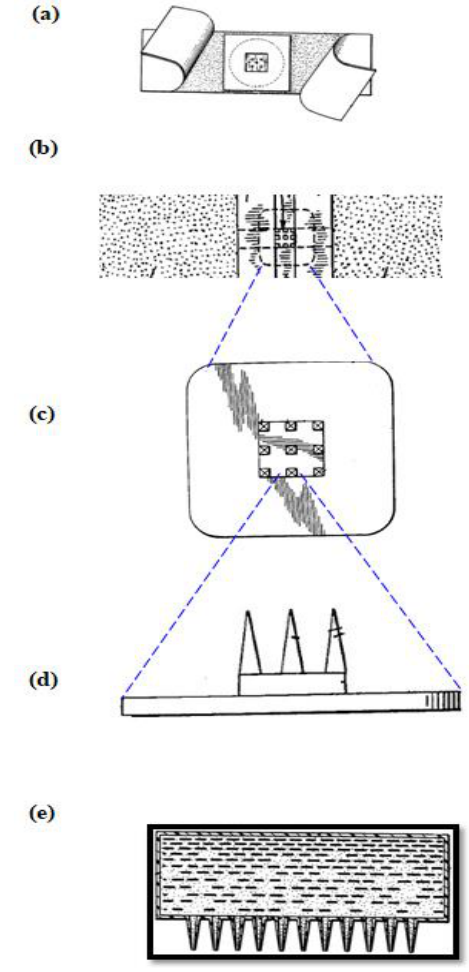
Figure 1. History of Microneedles (MNs) ( a ) Plan view of the microneedle device from reference [36] ( b – d ) Plan view of microneedle device, substantially to scale, blown-up to shown the MNs from reference [37] ( e ) MNs patented by Alza Corporation, from reference [38].